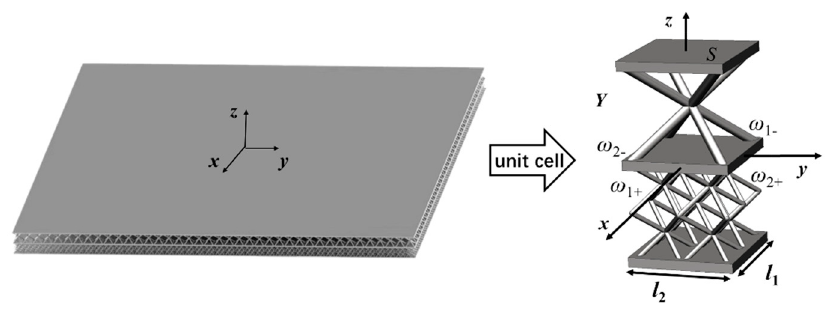
Figure 2. Bi-layer lattice-filled sandwich plate and its unit